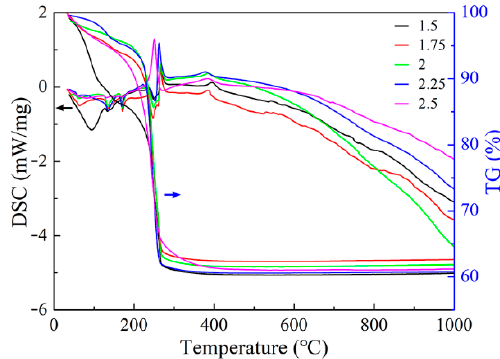
Figure 5. TG–DSC curves of the iron sol prepared with different NH 4 HCO 3 /Fe(NO 3 ) 3 · 9H 2 O ratio at 70 °C.